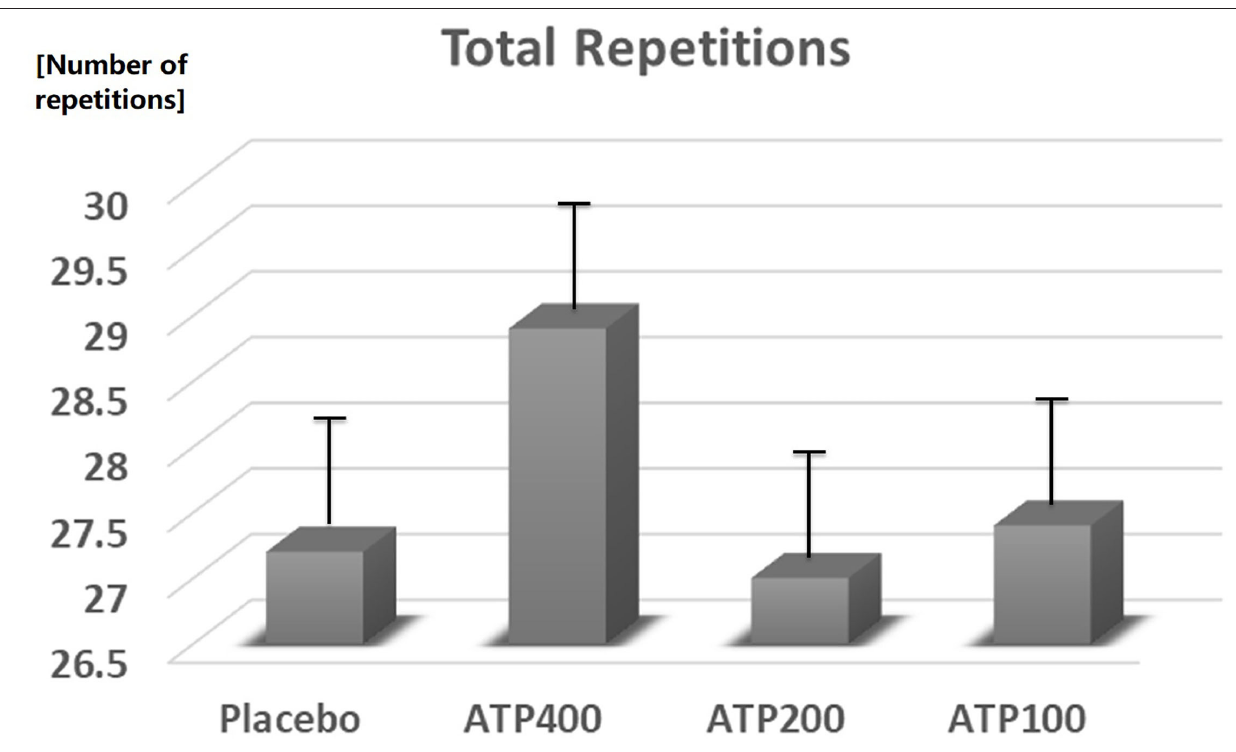
Frontiers in Sports and Active Living |